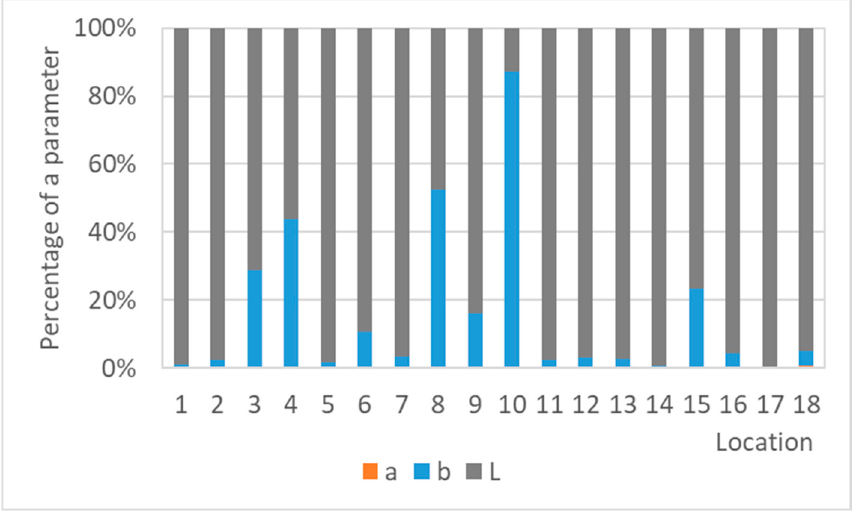
Figure 23. Percentage of the color parameters in the total color difference of zinc coupons exposed for a year.